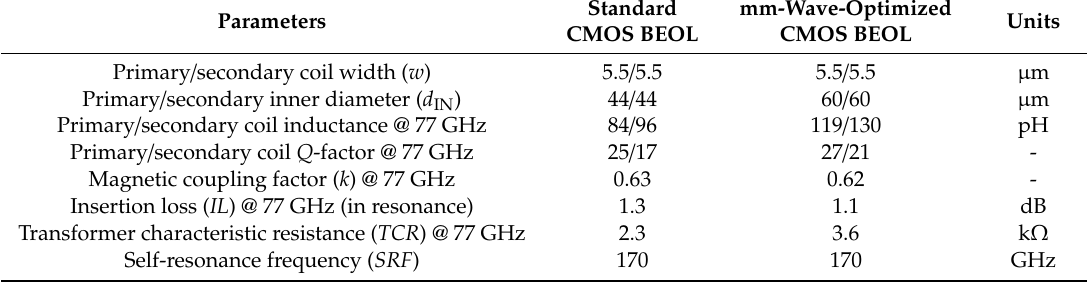
Table 1. Geometrical and performance parameter comparison for the stacked transformer T 1 .